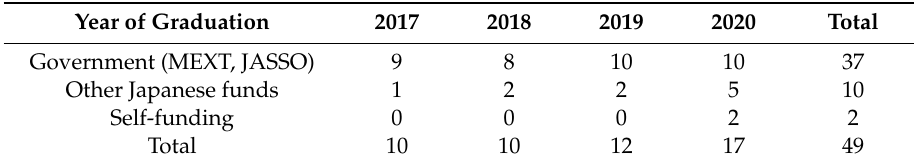
Table 1. Outbound student mobility Al-Farabi Kazakh National University (Department of Far East) to Japanese universities between 2016 and